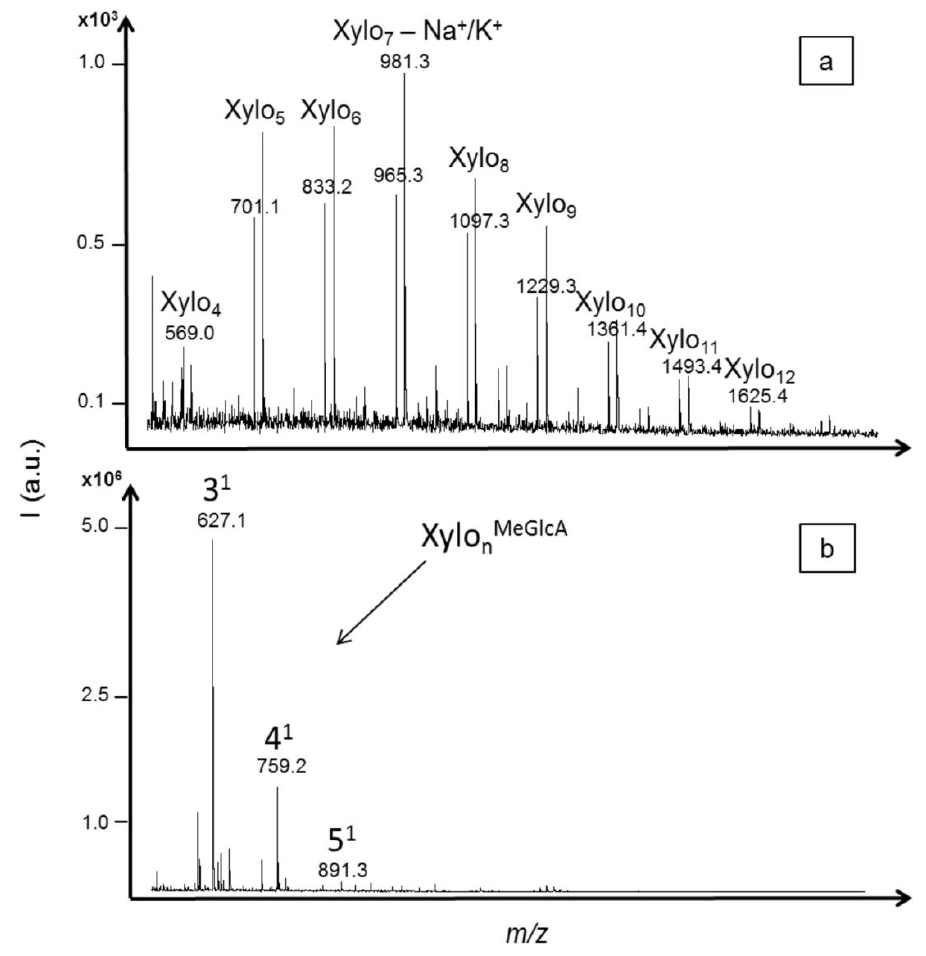
Figure 4. MALDI mass spectra of xylo-oligosaccharides (XOS) produced from xylan hydrolysis by ( a ) trifluoroacetic acid (TFA) 2 M; and ( b ) a commercial endo-1,4-xylanase from Trichoderma longibrachiatum . Neutral XOS were identified from acid hydrolysis based on their m/z values including one sodium or one potassium adduct. Acidic XOS corresponding to xylose units branched with one methylglucuronic acid were identified from enzymatic hydrolysis based on their m/z values including one sodium